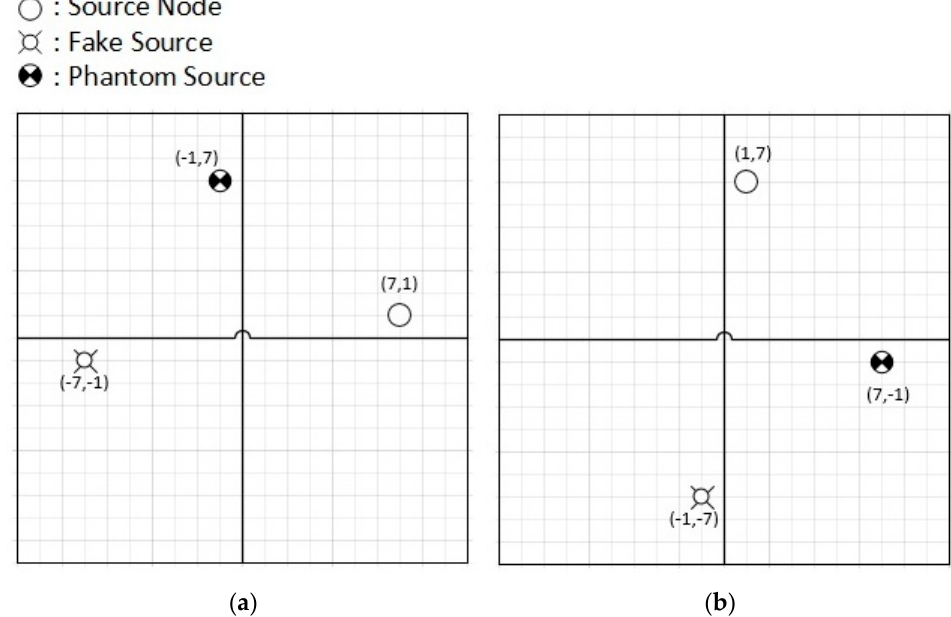
Figure 8. ( a ) and ( b ) are showing two different situations of Source Node (SN) in first